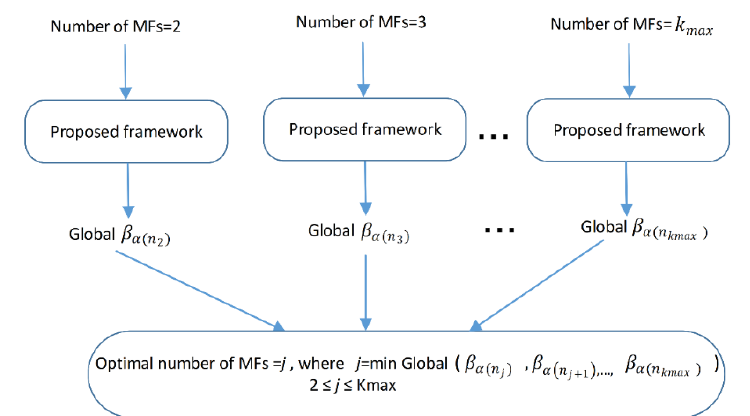
Figure 8. Finding the optimal number of trapezoidal membership